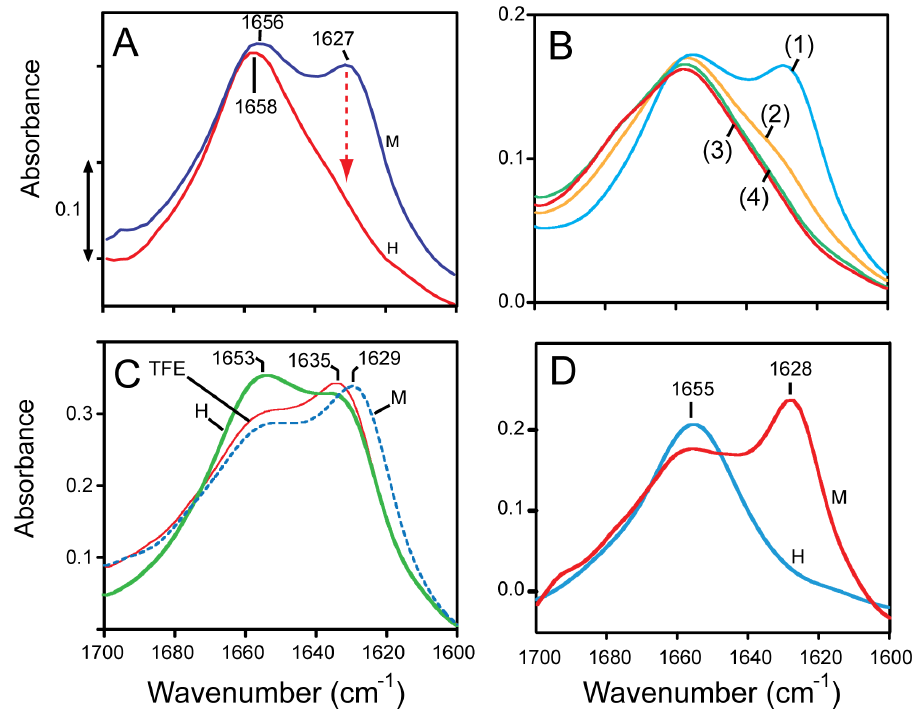
Figure 3. Secondary structure of p7 protein in lipid bilayers. (A) amide I region corresponding to recombinant p7 protein reconstituted into hydrated DMPC bilayers by the dialysis method, after having been solubilized and dried from methanol (M, blue) or HFIP (H, red); (B) Same for a sample reconstituted by the direct method after drying from methanol (1), after freeze-thawing (2), after extrusion (3), and supernatant after 5 min centrifugation of the proteoliposomes at 2,000 g (4); (C) Same for sample obtained by the addition method, where p7 was dissolved at , 10 mg/ml in the indicated solvents: MeOH, HFIP or TFE; (D), Amide I region of dry recombinant p7 protein obtained after lyophilizing a solution of p7 dissolved in either methanol (M) or HFIP (H).